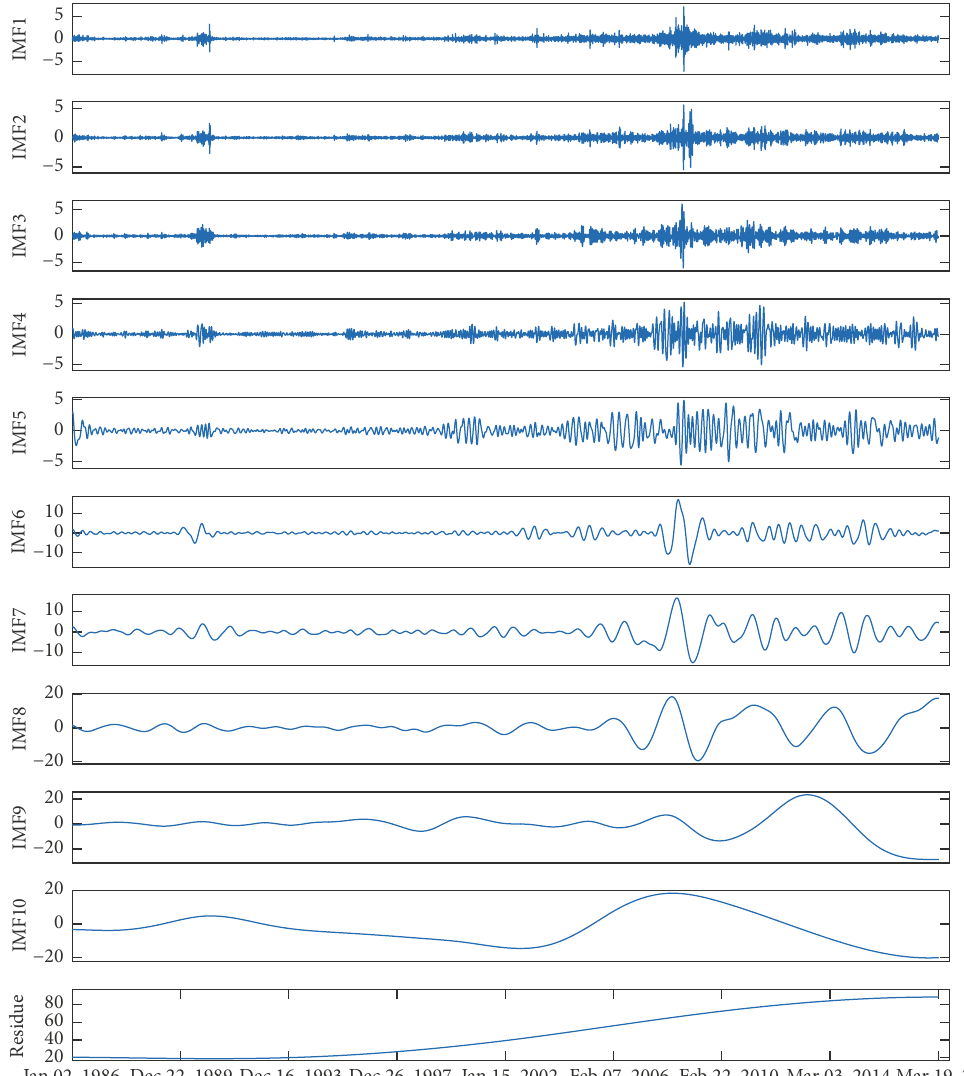
Figure 5: The IMFs and residue of WTI crude oil prices by CEEMDAN.